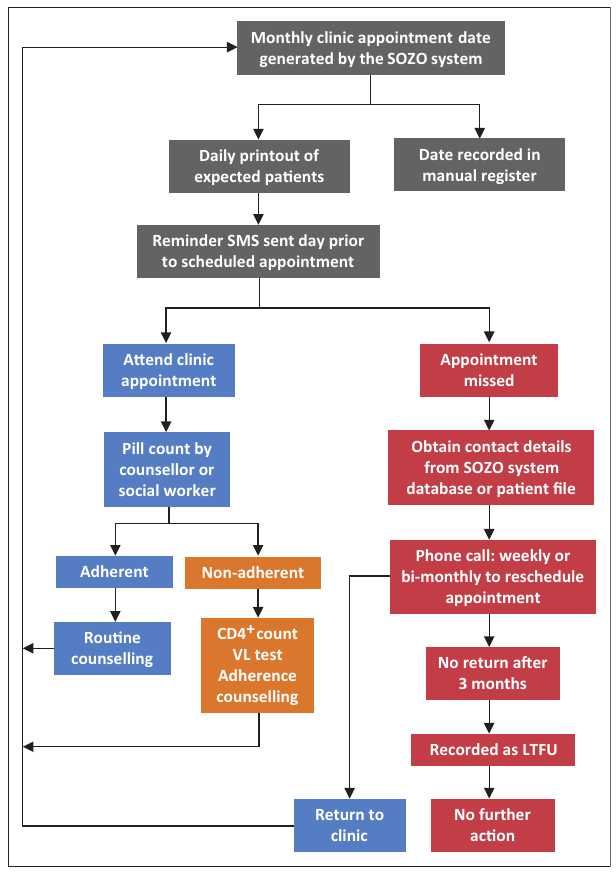
FIGURE 1: Flow process of monitoring and tracking patients on antiretroviral treatment at Sediba Hope Medical